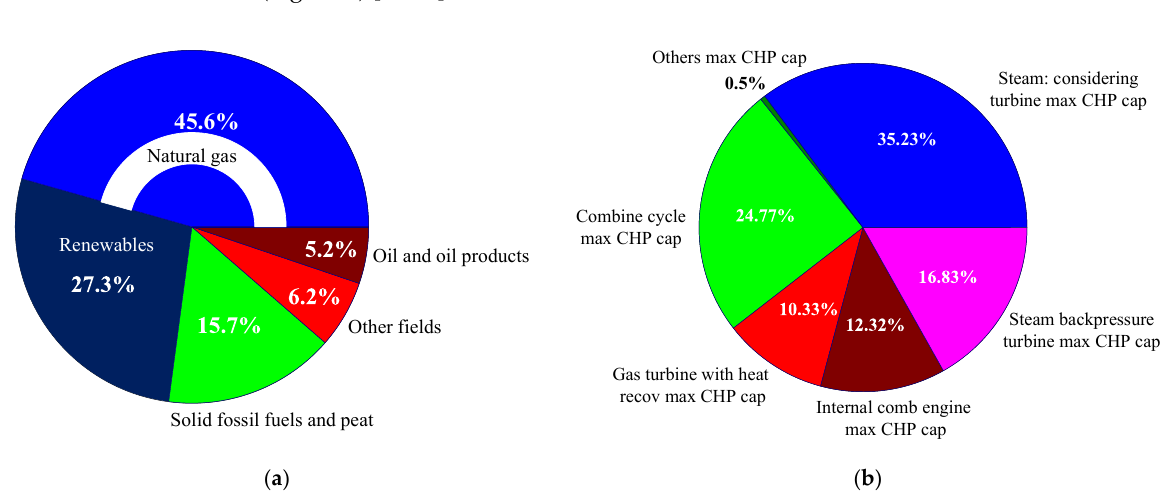
Figure 3. ( a ) Percentage of CHP fuel mix in 2017 by type, ( b ) CHP systems in 2015 by technology (right) in the case of EU-28.